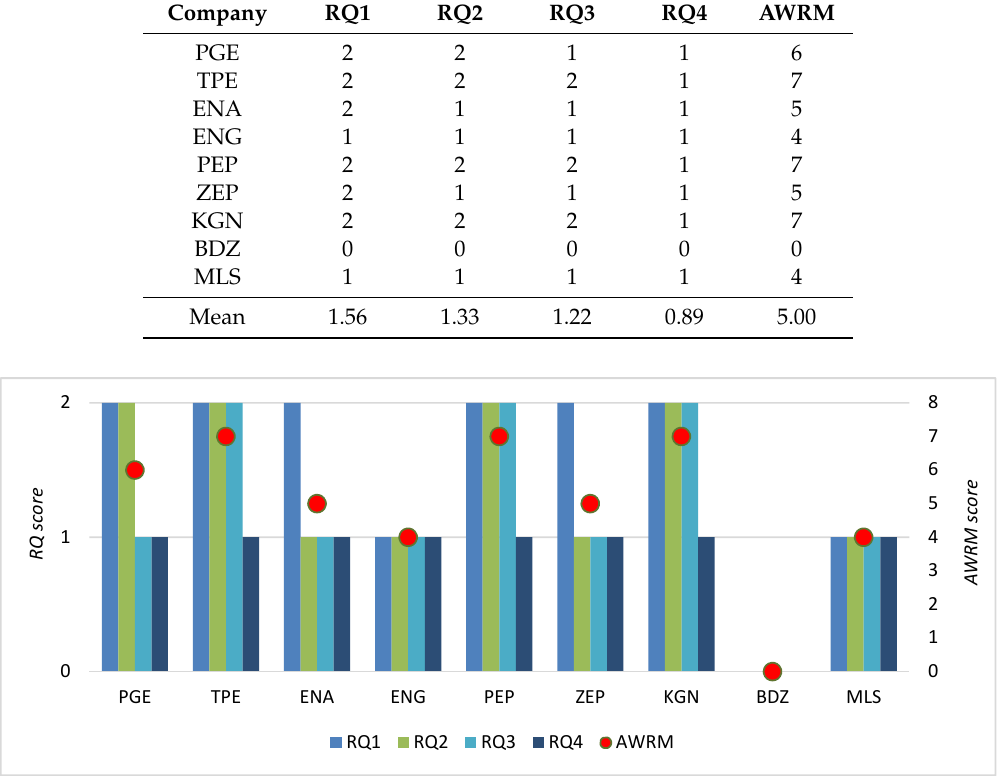
Table 4. Synthesis of the results of textual content analysis. AWRM, average weather risk management score.